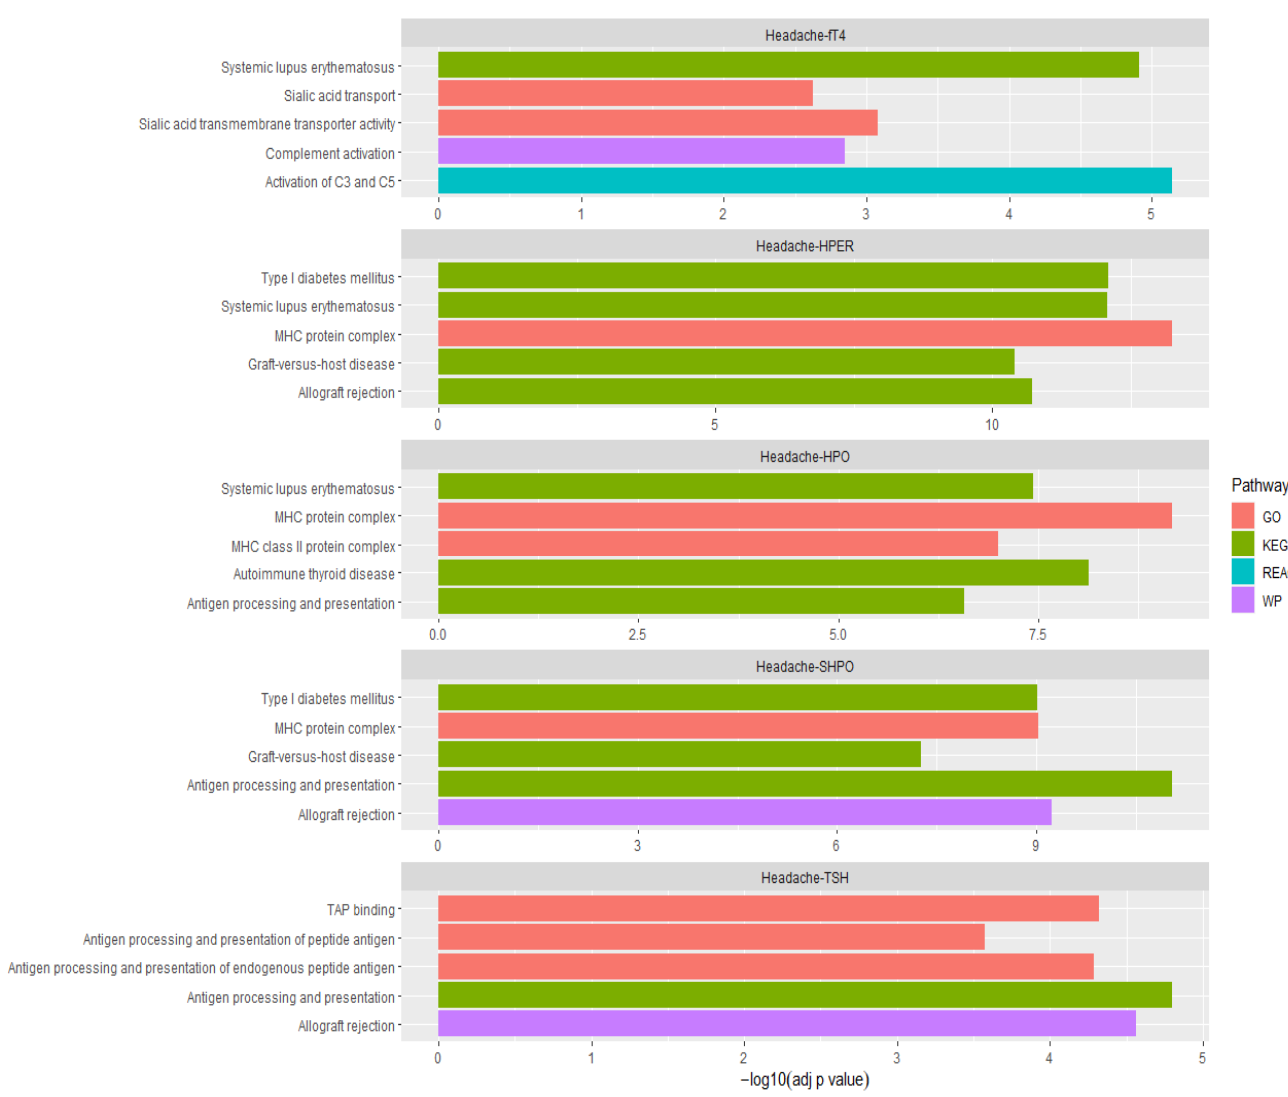
Figure 2. Top five significantly enriched pathways (GO, KEGG, REAC, and WP) across all headache and thyroid traits. (HPO, hypothyroidism; HPER, hyperthyroidism; SHPO, secondary hypothyroid- ism; TSH, thyroid stimulating hormone; fT4, free thyroxine; GO, Gene Ontology; KEGG, Kyoto En- cyclopedia of Genes; REAC, Reactome; WP, Wiki Pathways) .